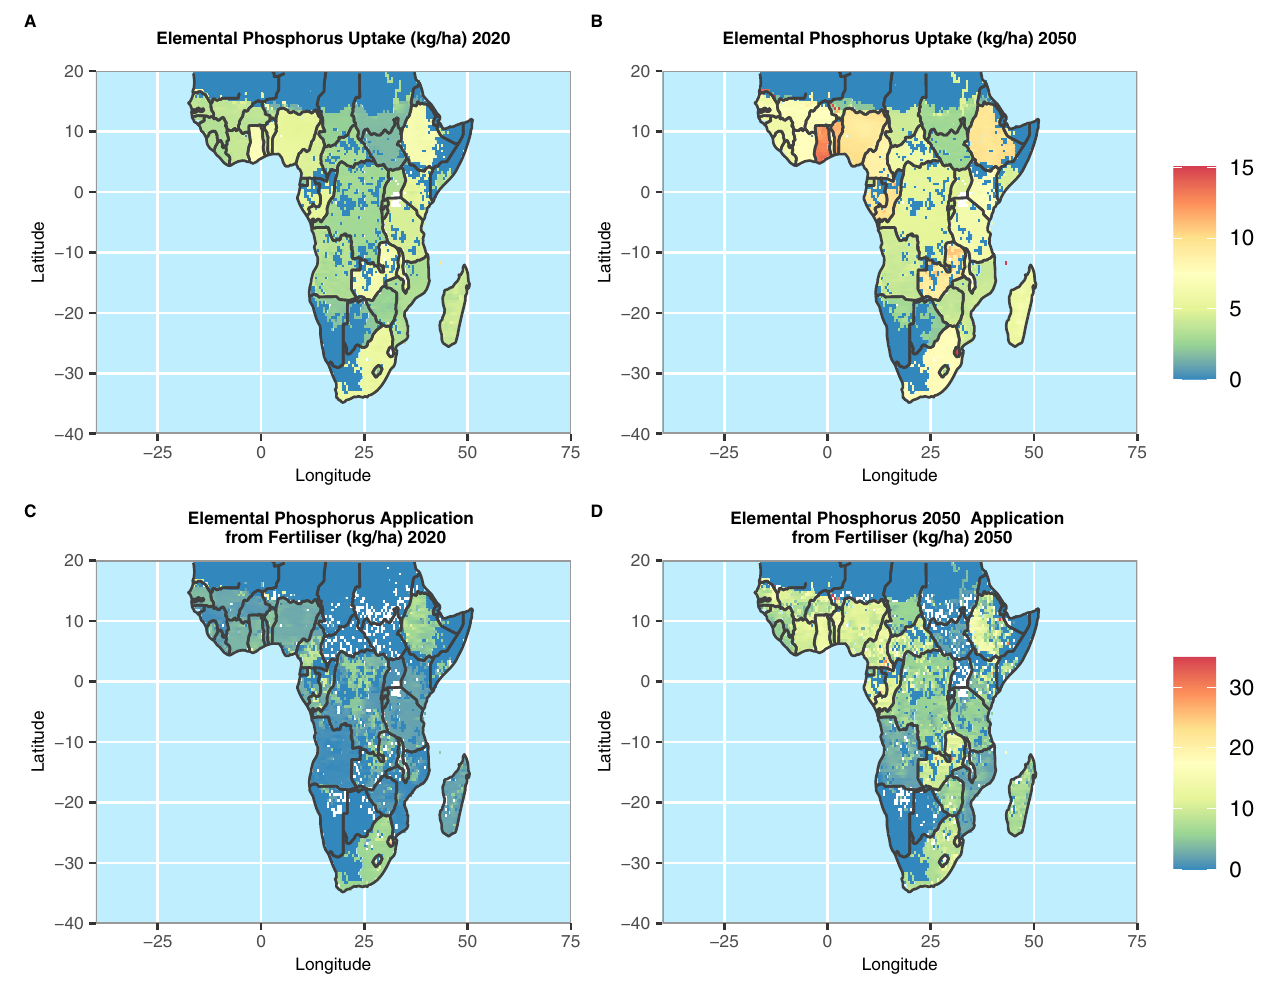
Fig.3|Spatialdistributionofannualphosphorusuptakeandapplicationrates (kgha-1)inSub-SaharanAfricafor2020and2050. Spatialdistributionof annual phosphorusuptakerates(kgha − 1 )inSub-SaharanAfricafor2020( A )and2050( B ). Spatial distribution of annual elemental phosphorus application rates from